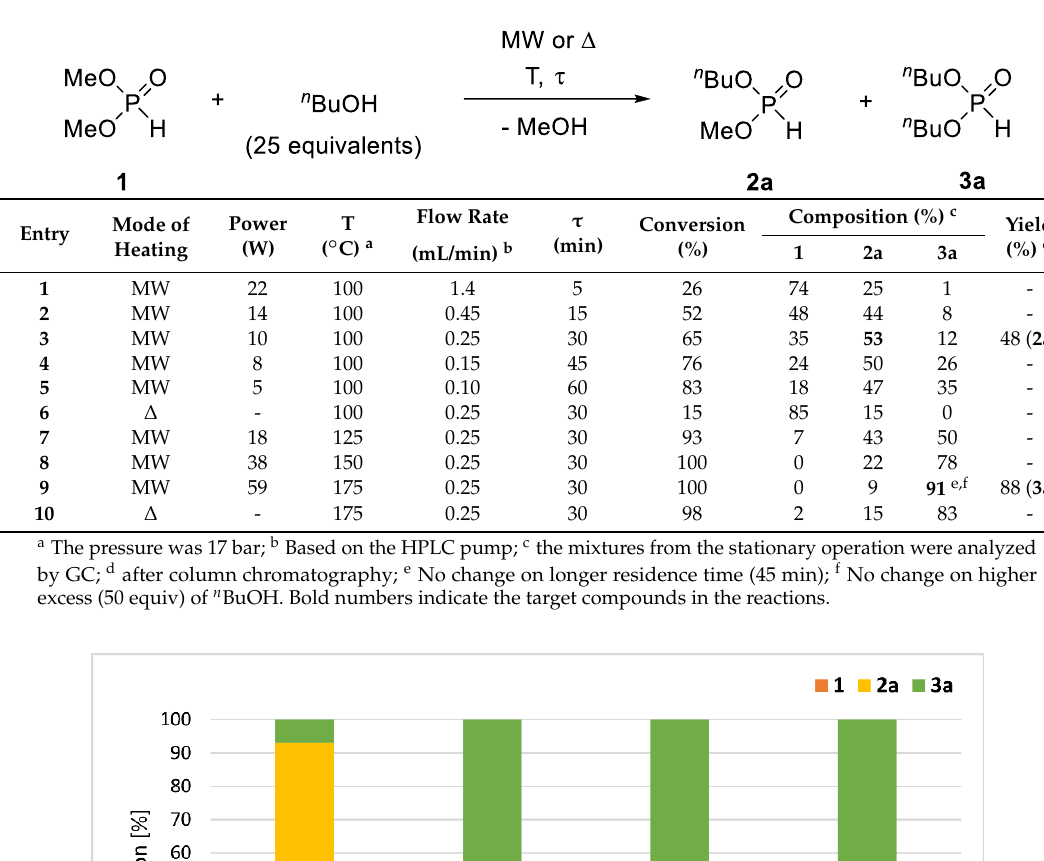
Table 3. Continuous flow alcoholysis of DMP with n BuOH.